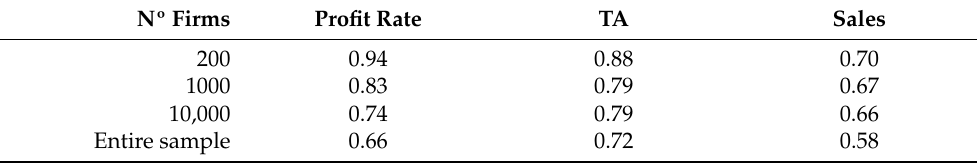
Table 2. Median of the estimates of the shape parameter reported in Figure 5.